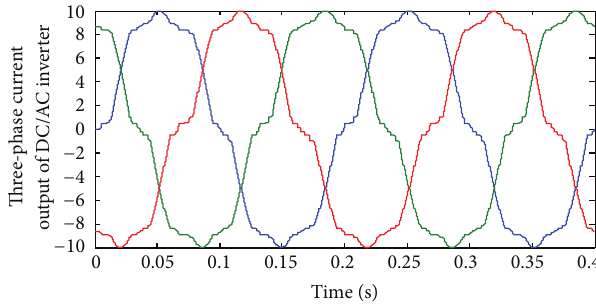
Figure 18: Inverter’s output current in best case